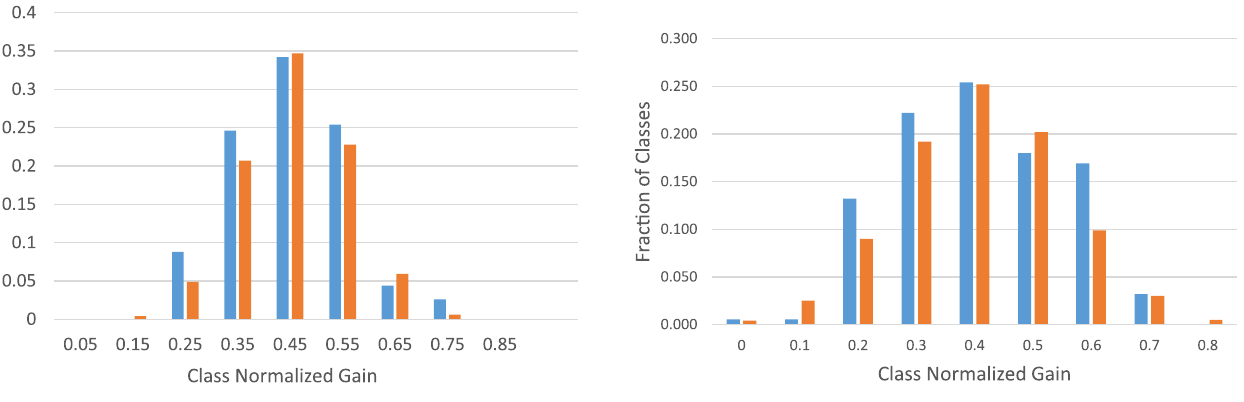
FIG. 1. Comparison of the distribution of class normalized gains for 114 IE classes with similar Lawson scores, median of 0.46, and a standard deviation of 0.10 (blue) with a normal distribution having the same median and SD